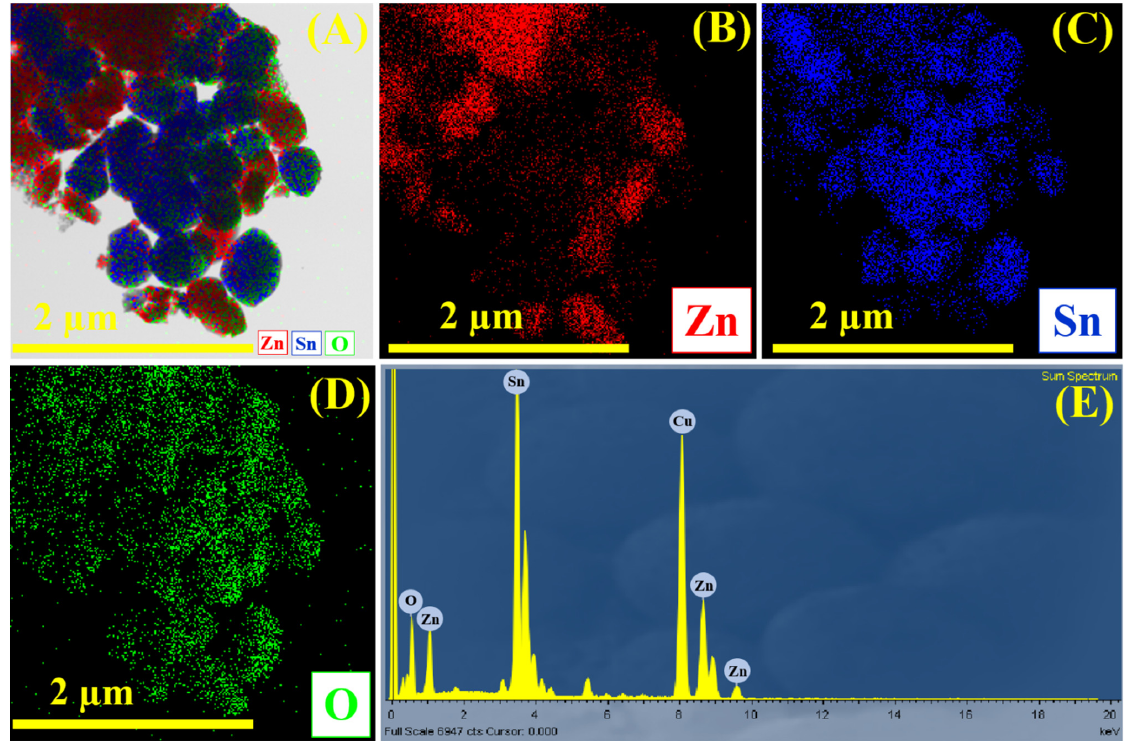
Figure 3. FE-SEM elemental mapping of Zn, Sn, and O ( A ); elemental mapping of ( B ) Zn, ( C ) Sn, and ( D ) O; and ( E ) EDX spectrum of ZTO/TO MPs (Cu is from the copper grid).